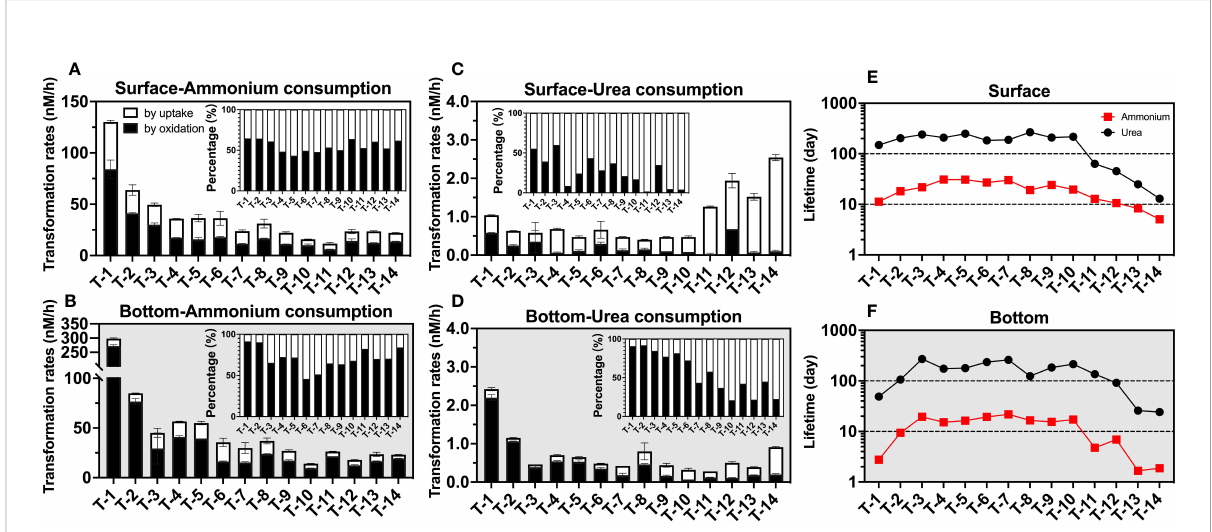
FIGURE 8 Consumption rates (nM/h) as well as lifetimes (day) of ammonium and urea. The graphs show the consumption rate of ammonium in the surface (A) and bottom (B) layers; the consumption rate of urea in the surface (C) and bottom (D) layers; and the lifetimes of urea and ammonium in the surface (E) and bottom (F) layers. In (A – D) , white represents consumption by uptake, black represents consumption by oxidation, the error bars represent the standard deviation of the two biological replicates, and the subplots indicate the percentage of different processes; in (E, F) , the red squares represent ammonium and the black circles represent urea.